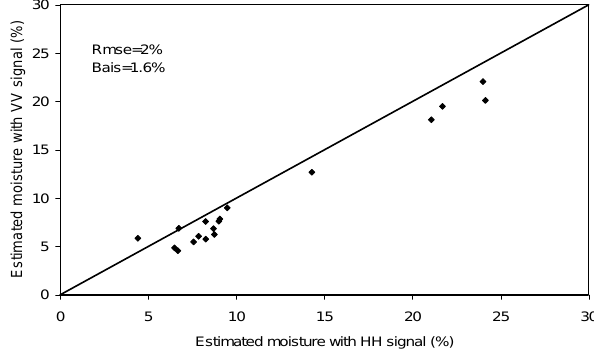
Fig. 6. Inter-comparison between HH and VV radar signal moisture